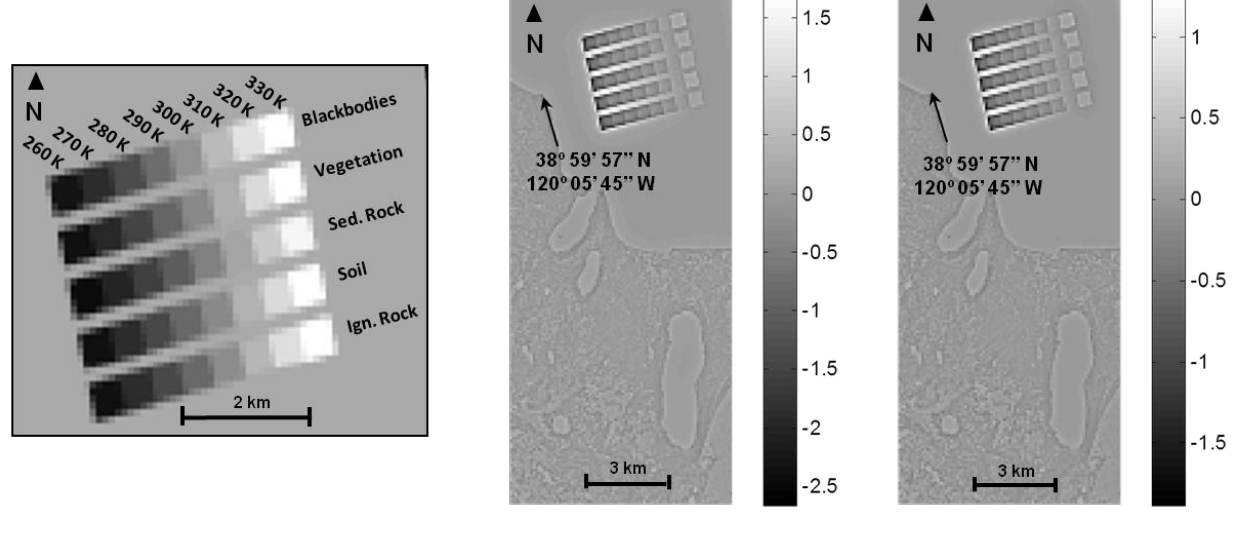
Figure 6. Apparent temperature difference map (in units of Kelvin) between the specified ESF image and the observed ESF image for the 10.8 μm band ( center ) and the 12.0 μm band ( right ) through a MODTRAN mid-latitude summer atmosphere. The test targets located in the lake had the thermal and material properties illustrated ( left